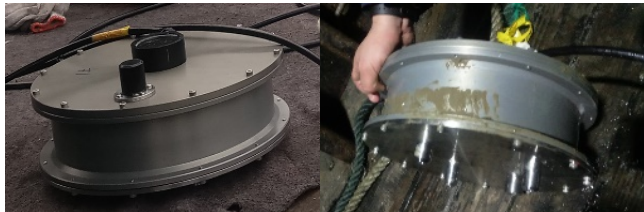
Figure 33. Design of a cylindrical double-tank OBS made up of titanium alloy. Figure 34. The OBS before deployment to the seafloor and just after the recovery.